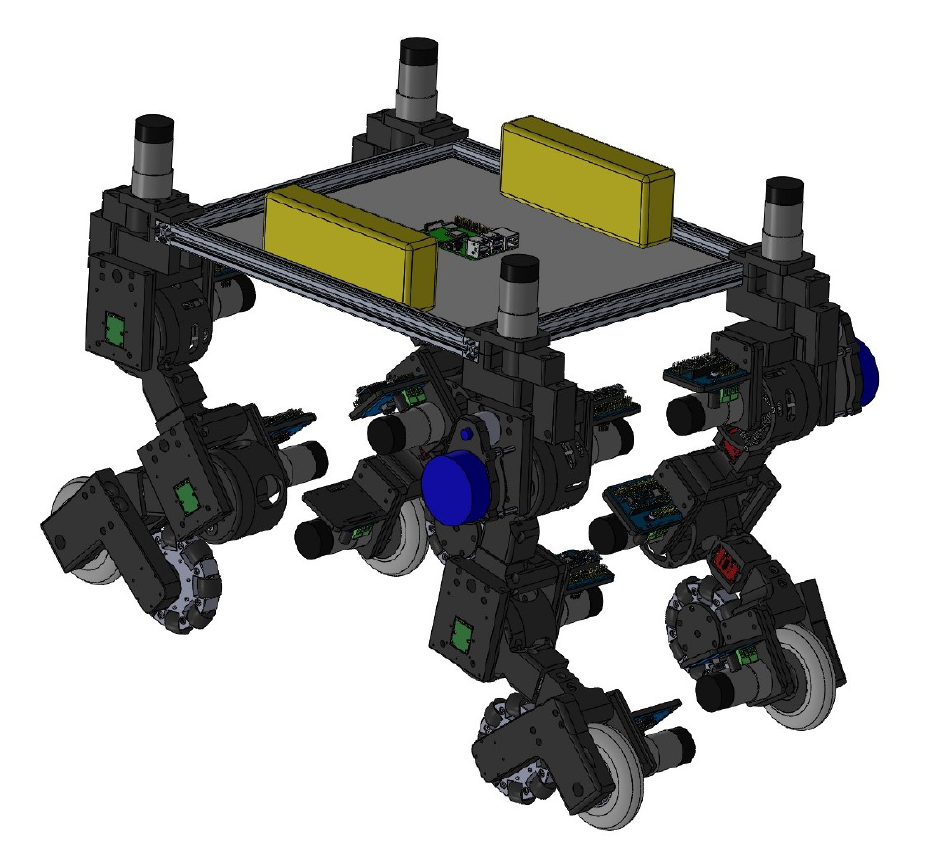
Figure 19. Quadruped configuration CAD